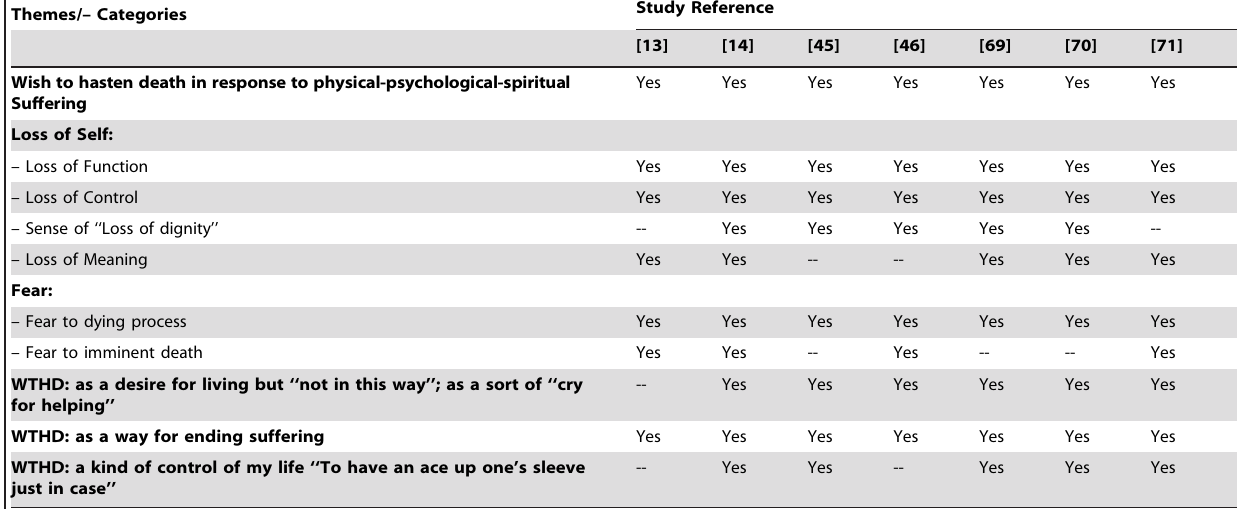
Table 5. Themes identified in each